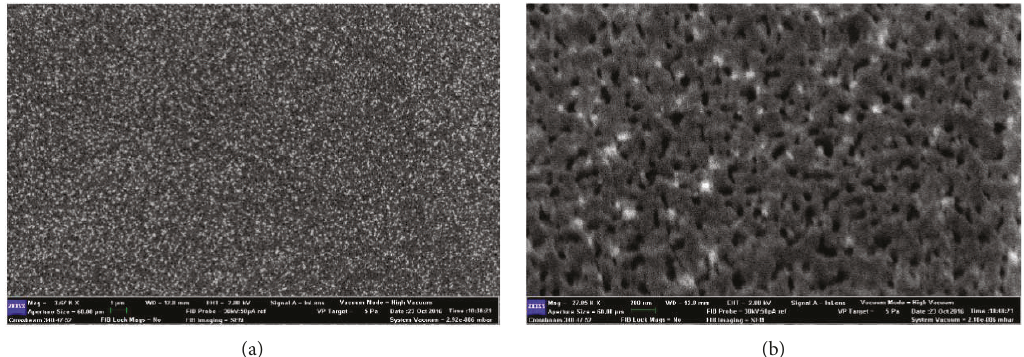
Figure 2: SEM image of the printed AgNP sample through FESEM with a voltage potential of 2kV. (a) Scale bar =1 μ m. (b) Scale bar =200nm.